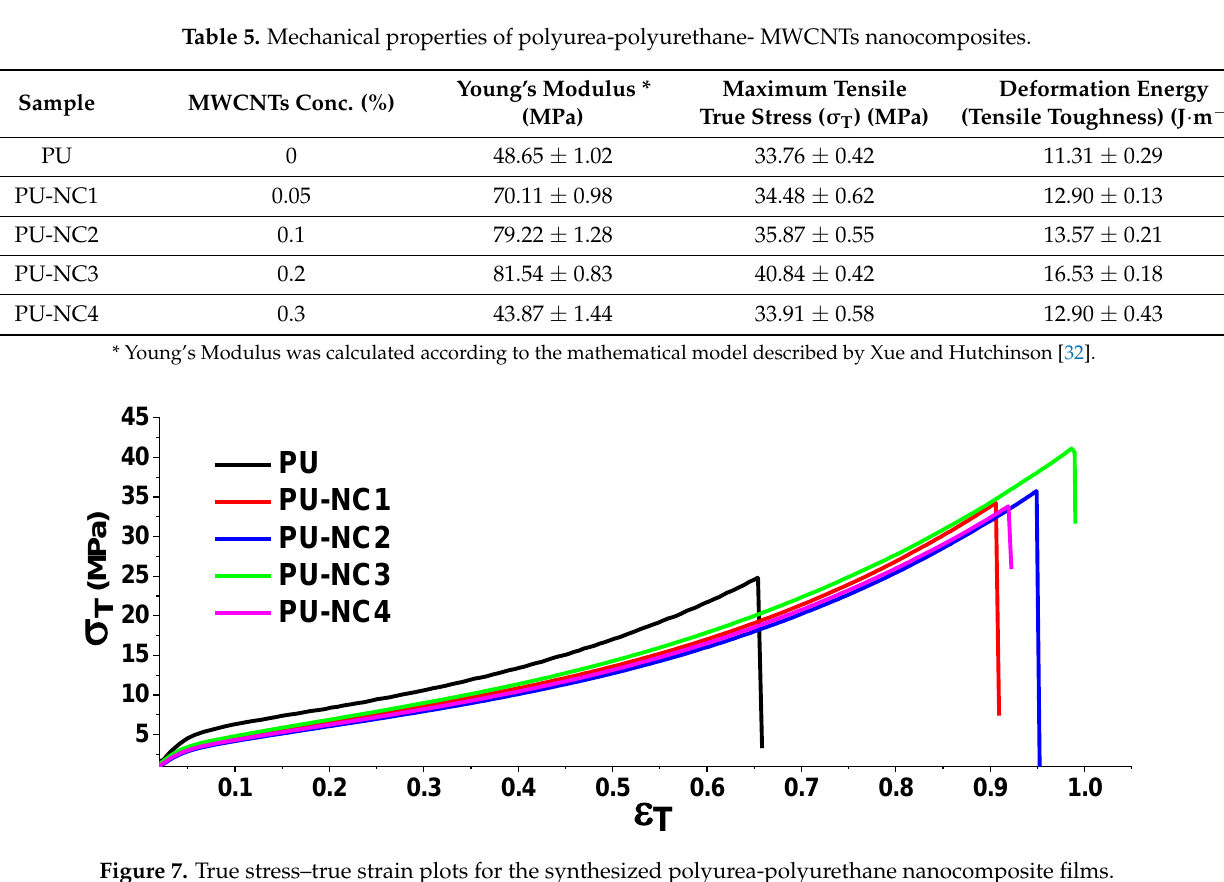
Figure 7. True stress–true strain plots for the synthesized polyurea-polyurethane nanocomposite films.